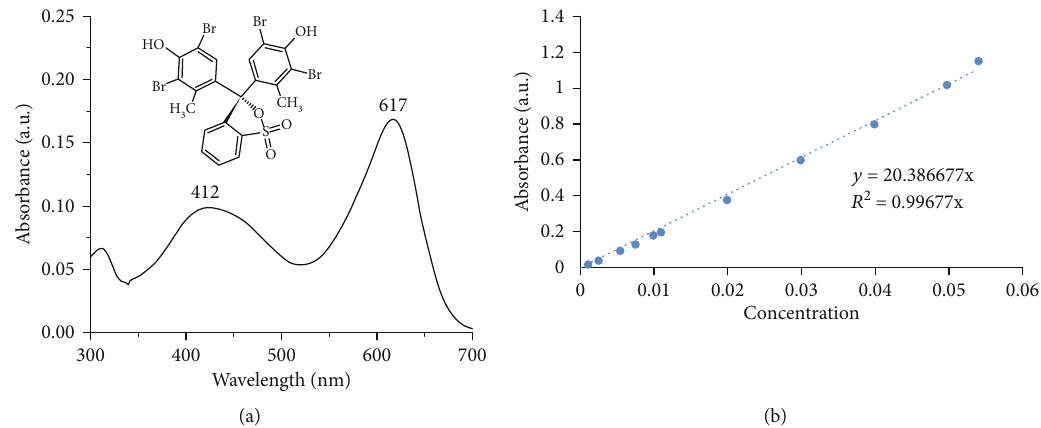
Figure 3: Chemical structure of BCG: (a) UV-Vis spectra and absorbance; (b) concentration calibration curve.